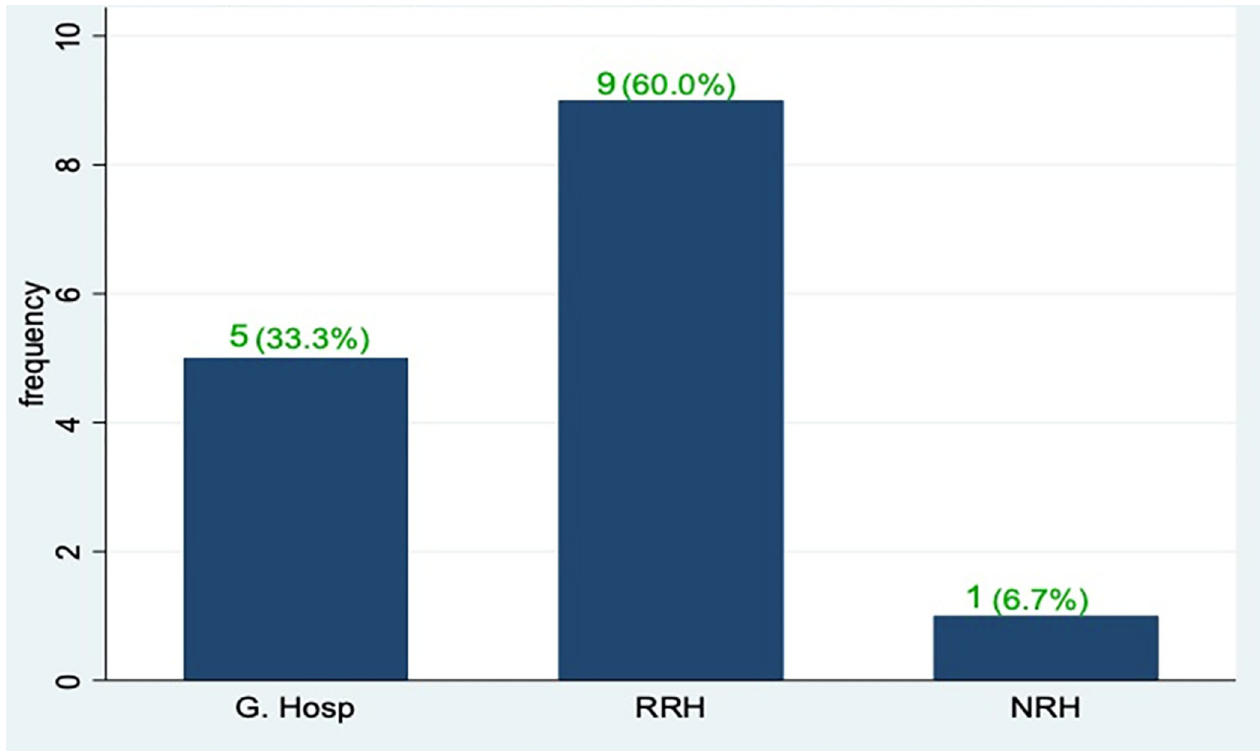
Fig 1. A graph showing the distribution of HFs